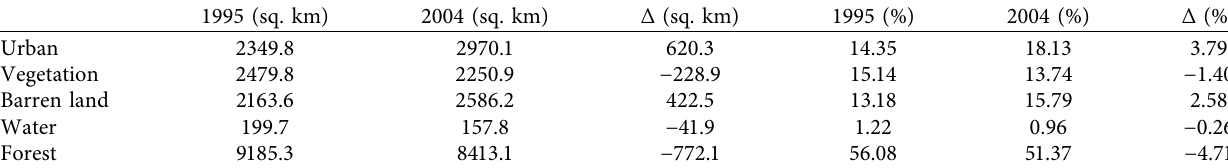
Table 4: A real change of LULC categories in different time spans between 1995 and 2004.